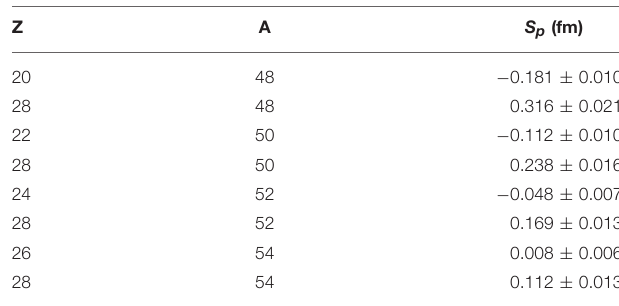
TABLE 3 | Proton skins, S p , in the mass range 48–54.